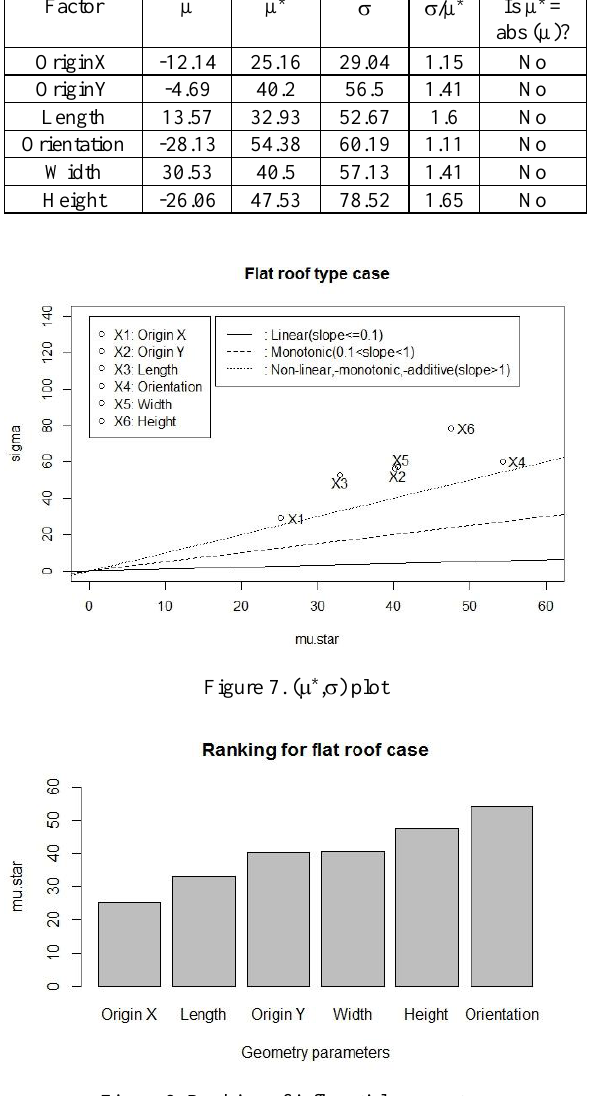
Figure 8. Ranking of influential